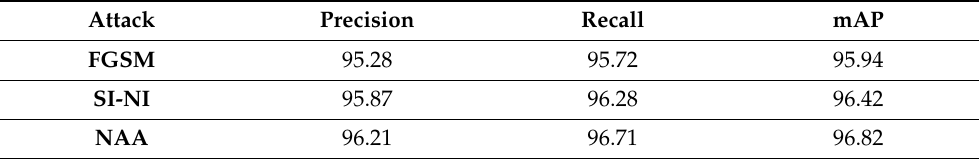
Table 2. Defence effect comparison of different attack